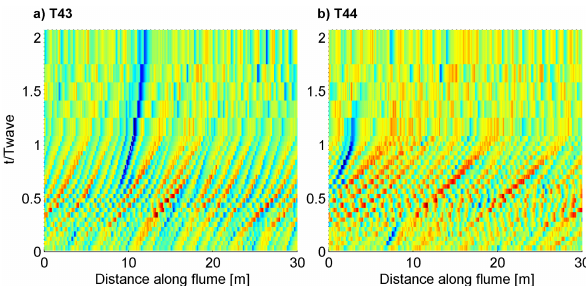
Figure 4. Color map plots of bed elevation for the fast ( a : T wave =3.5h) and slow ( b : T wave =7h) flood waves based on the bed profiles from test 5 of Wijbenga and Van Nes (1986a). Bed ele- vations range from − 5cm (blue) to 5cm (red).